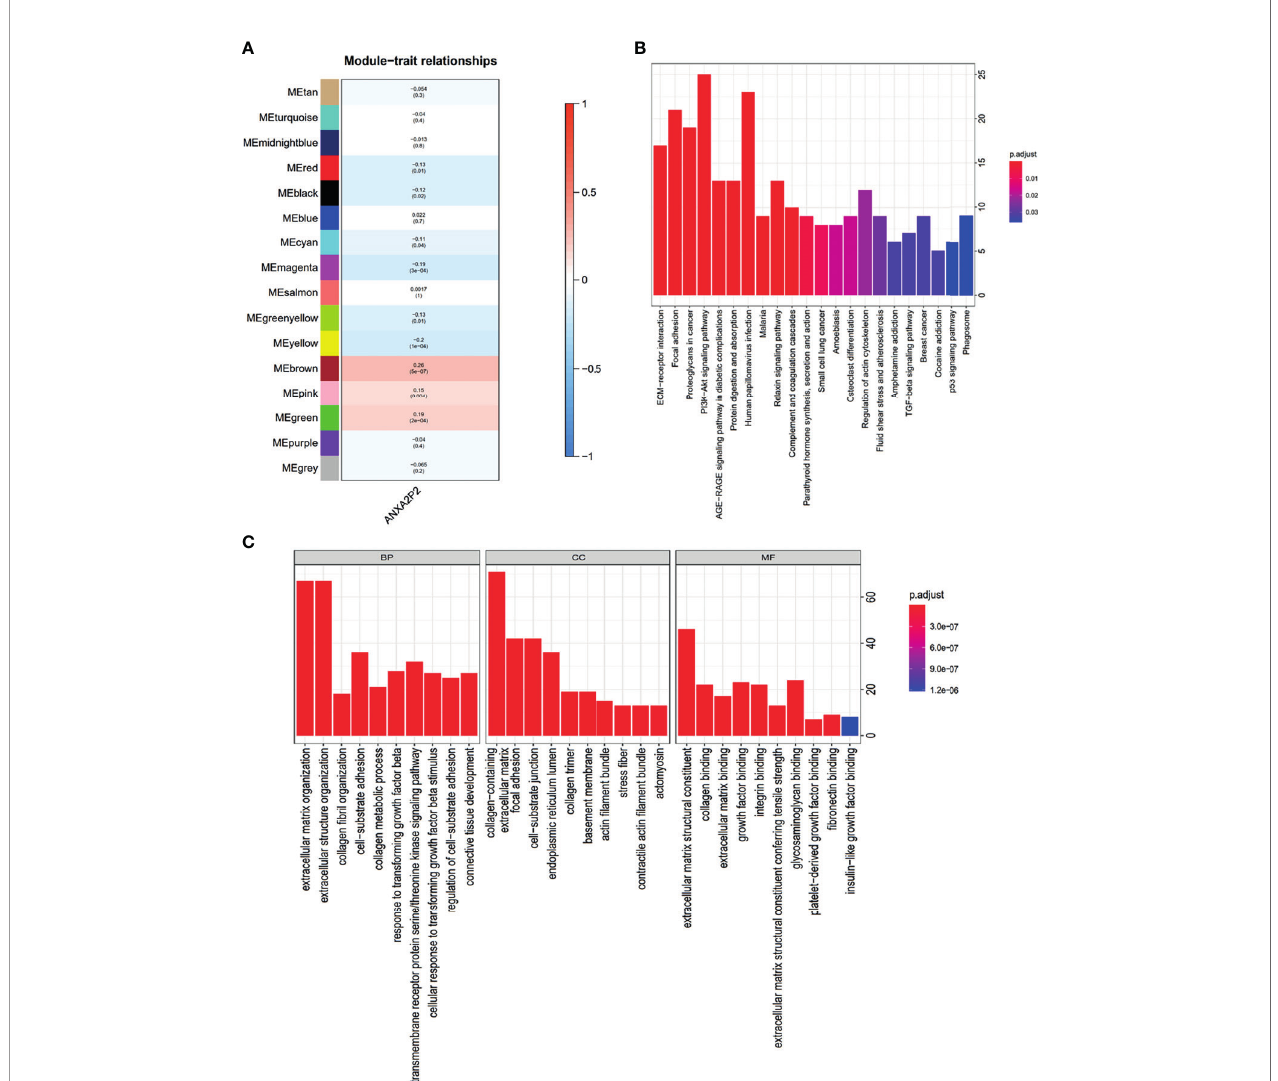
FIGURE 9 | WGCNA regulatory network analysis for ANXA2P2 in OV. (A) Correlation between various modules and ANXA2P2 expression. The top number means the coef fi cient among them, and the bottom number indicates the p -value. (B) KEGG enrichment pathway analysis was applied for genes with brown module meaning highest correlation. (C) GO term analysis for genes with brown module meaning highest